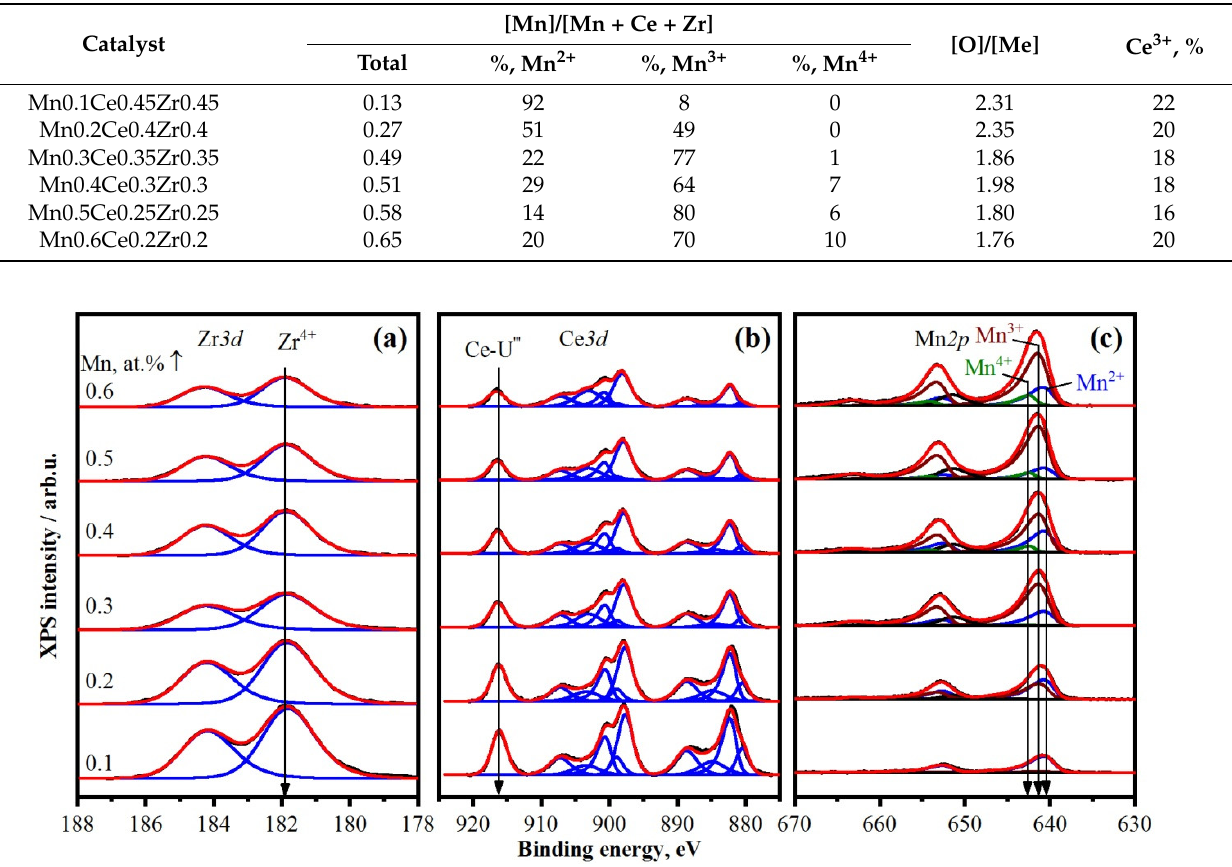
Table 4. Atomic ratios of the elements on the surface according to XPS results.